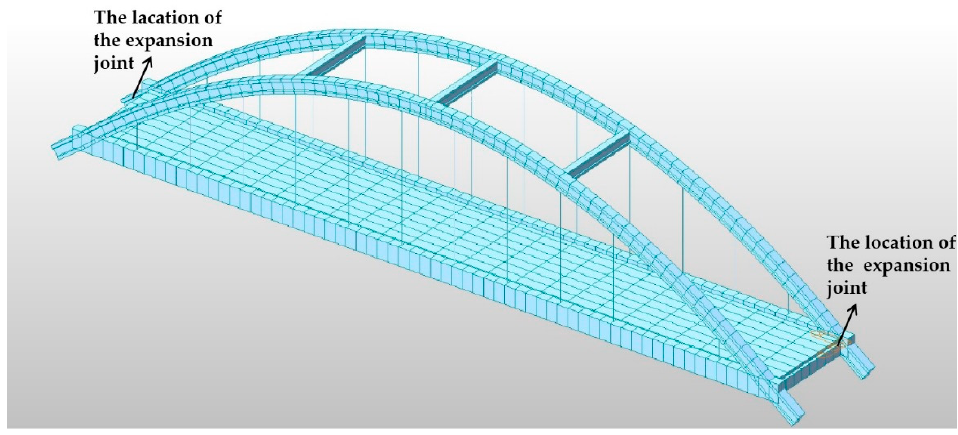
Figure 10. Finite element model of a TAB.